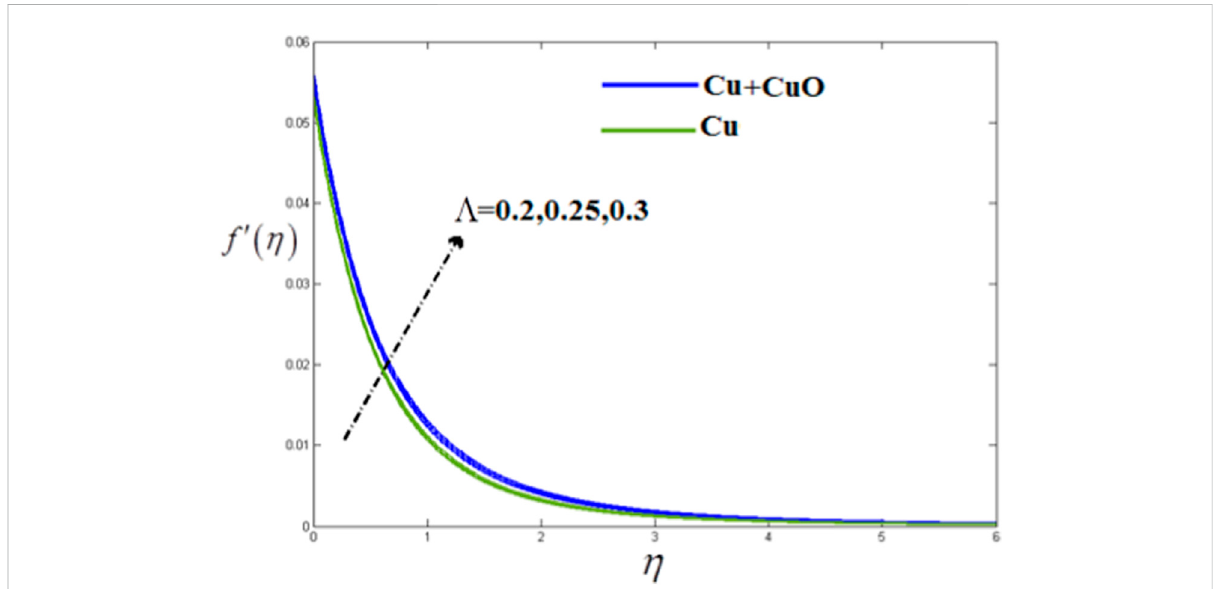
FIGURE 2 Λ versus f ′ ( η ) . When, ϕ